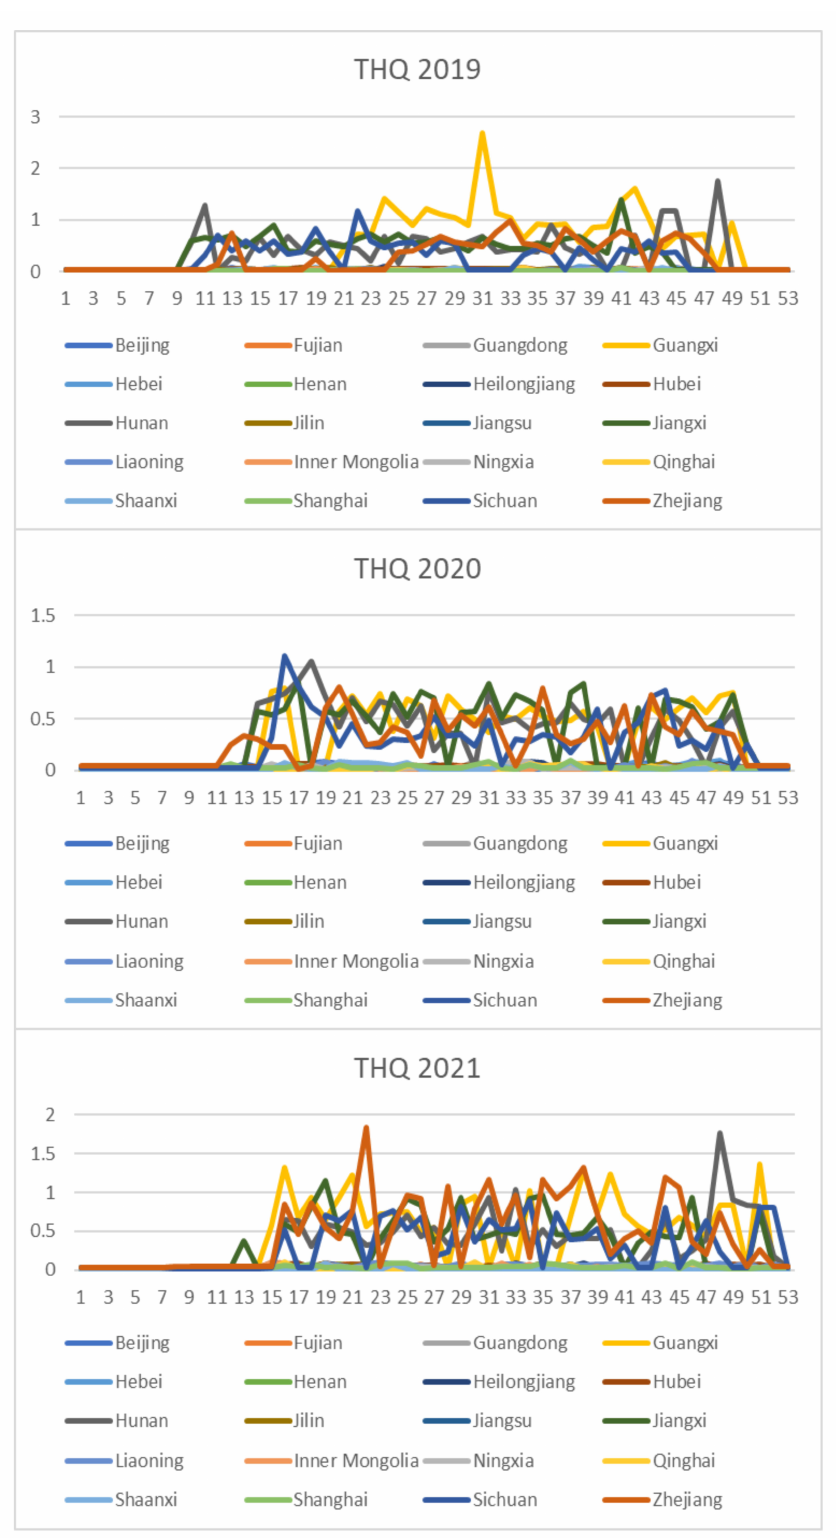
Figure 5. Dataset of rice safety risk assessment indicator